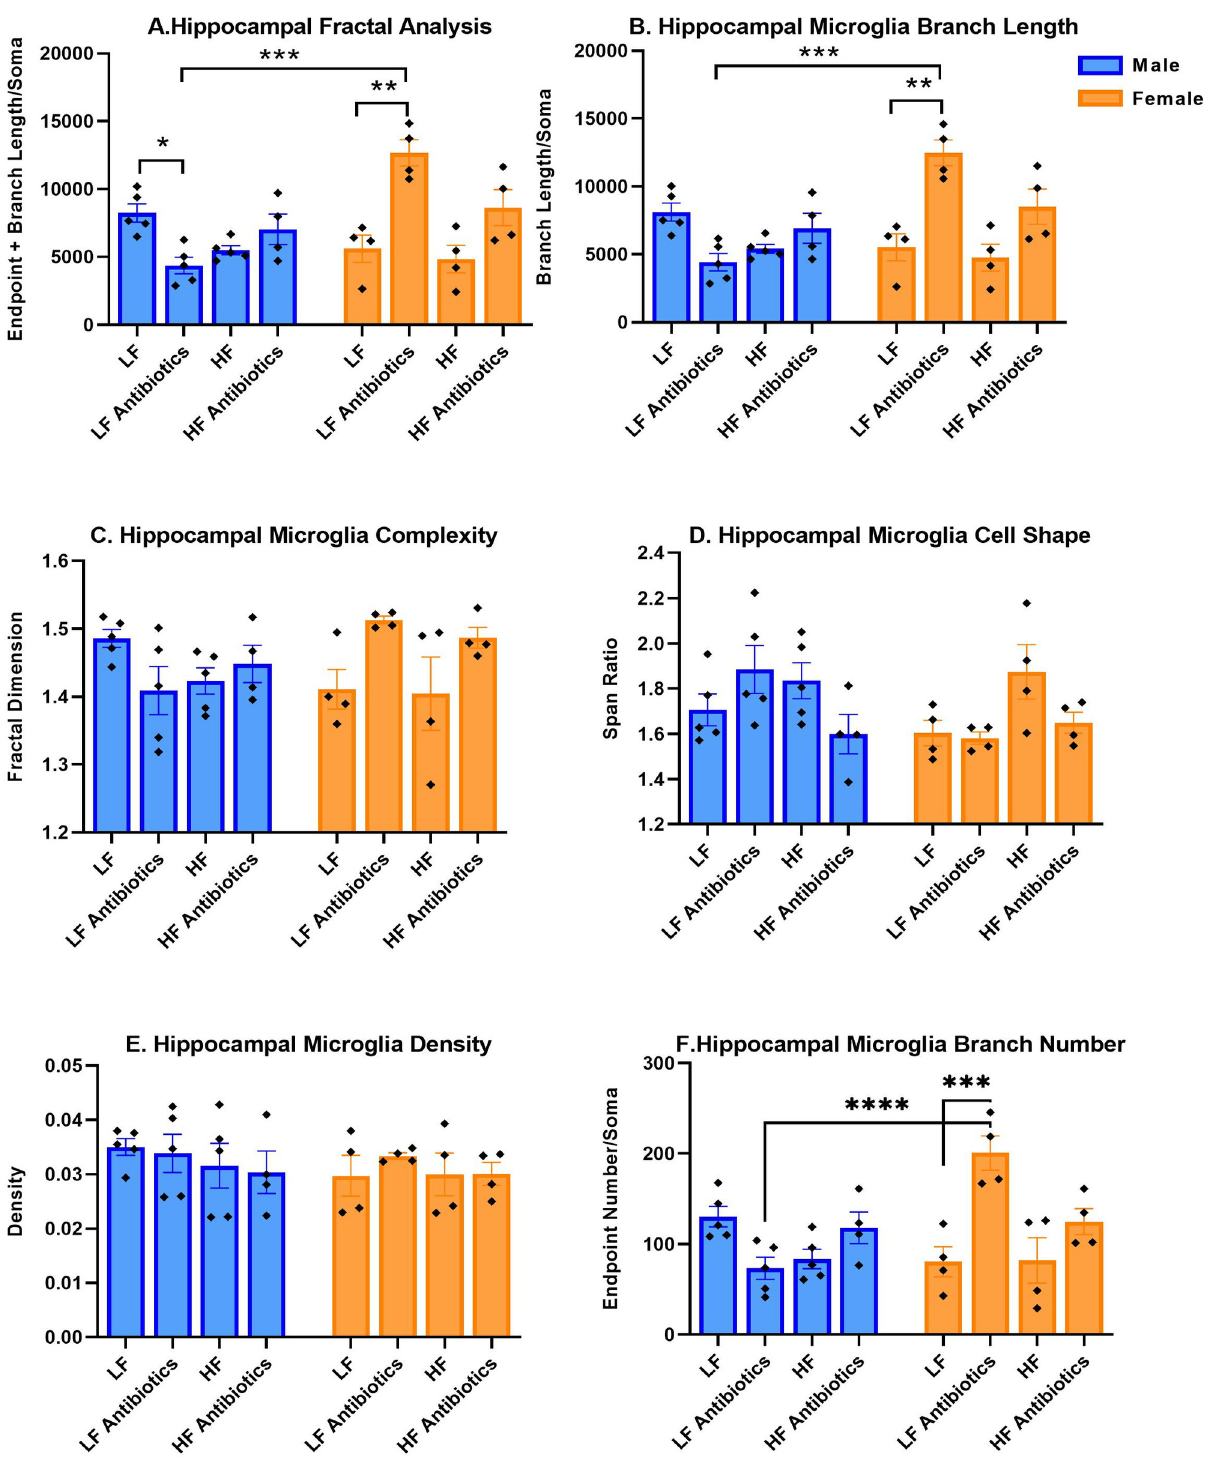
Fig 6. Microglial analysis (n = 4-5/group). The results for fractal analysis (A), branch length (B), cell complexity (C), cell shape (D), density (E), and summed endpoints (F) are shown. � p < 0.05; ��� p < 0.001; ���� p < 0.0001.